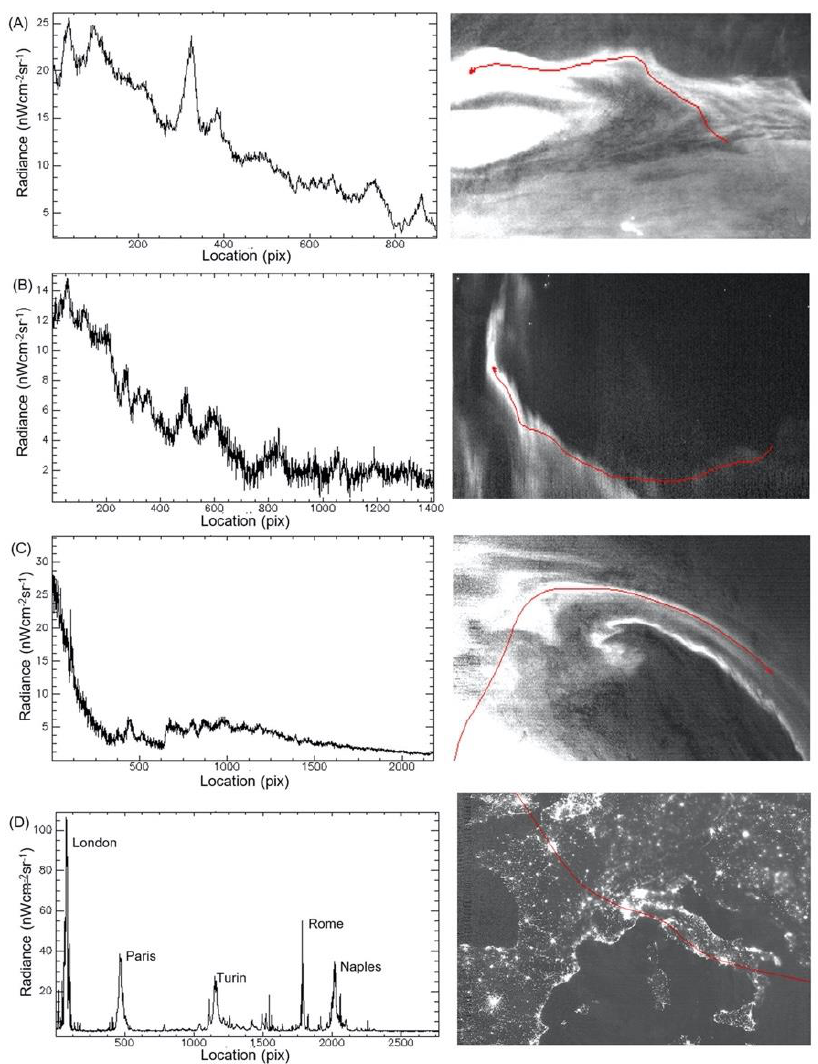
Figure 5. Cross section radiance measure and respective VIIRS images for ( A ) Aurora Borealis core, taken 11:18 UTC 13 February 2019, ( B ) Aurora Borealis fine structure, taken 11:18 UTC 13 February 2019, ( C ) Aurora Australis from core to fine structure, taken 19:30 UTC 5 February 2019, ( D ) Night-time Lights of Europe, taken 01:06 UTC 3 February 2019. All data acquired from NASA LAADS DAAC.